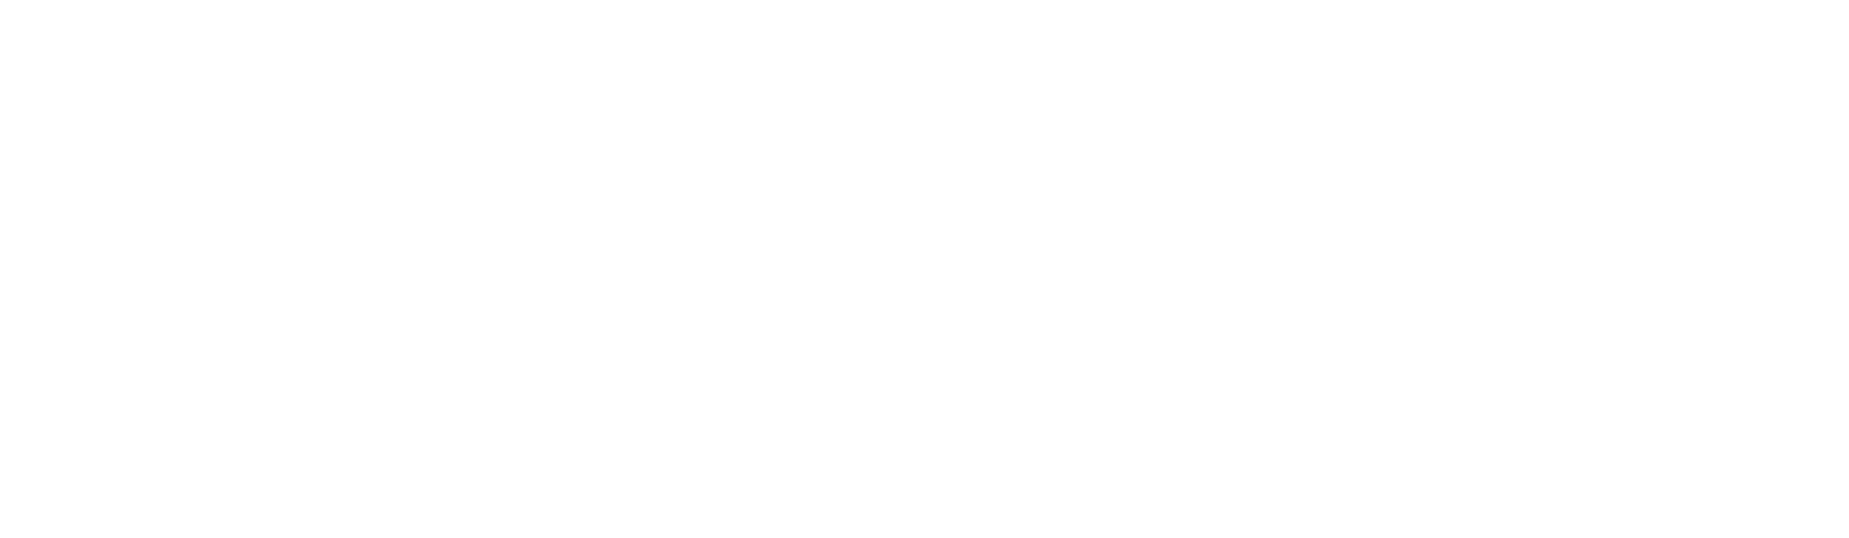
Table 2. Glycosidase inhibition studies from laboratory 2. Results expressed as % inhibition at ~400 μ M.